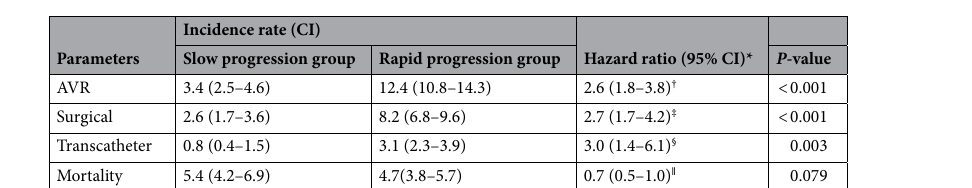
Figure 1. Classification of patients with moderate aortic stenosis using LTCM based on progression of MPG. ( A ) Raw LCTM results. ( B ) Smoothed LCTM results identify two distinct trajectories. LCTM latent class trajectory modeling, MPG mean pressure gradient.